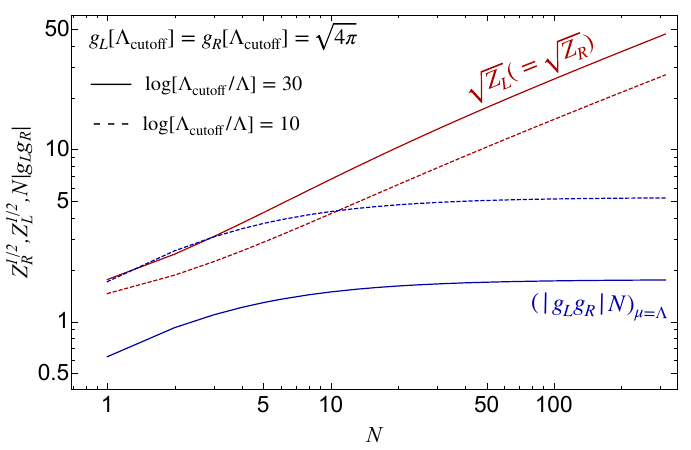
√ √ Figure 2 . The Z L (= Z R ) (red lines) and | g L g R | N at µ = Λ (blue lines) by varying the multiplicity N . The solid (dashed) lines are for the hierarchy log Λ cutoff / Λ = 30 and 10 respectively. dimension for L ( e ) 2 2